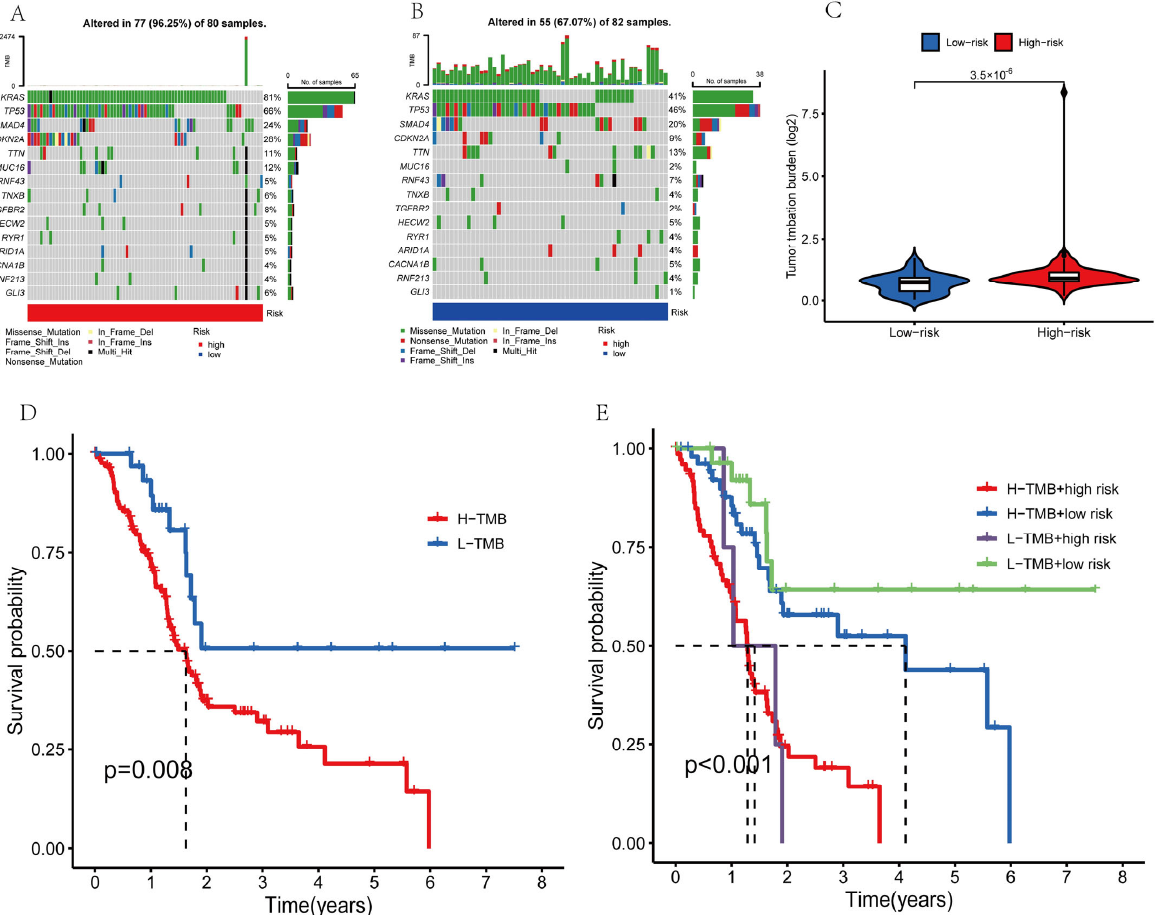
Figure 10. Tumor mutation analysis. ( A , B ) The top 15 genes with the most prevalent mutations in the high ‐ risk and low ‐ risk populations. ( C ) Violin plot of TBM. ( D , E ) The overall survival curves for different subgroups.